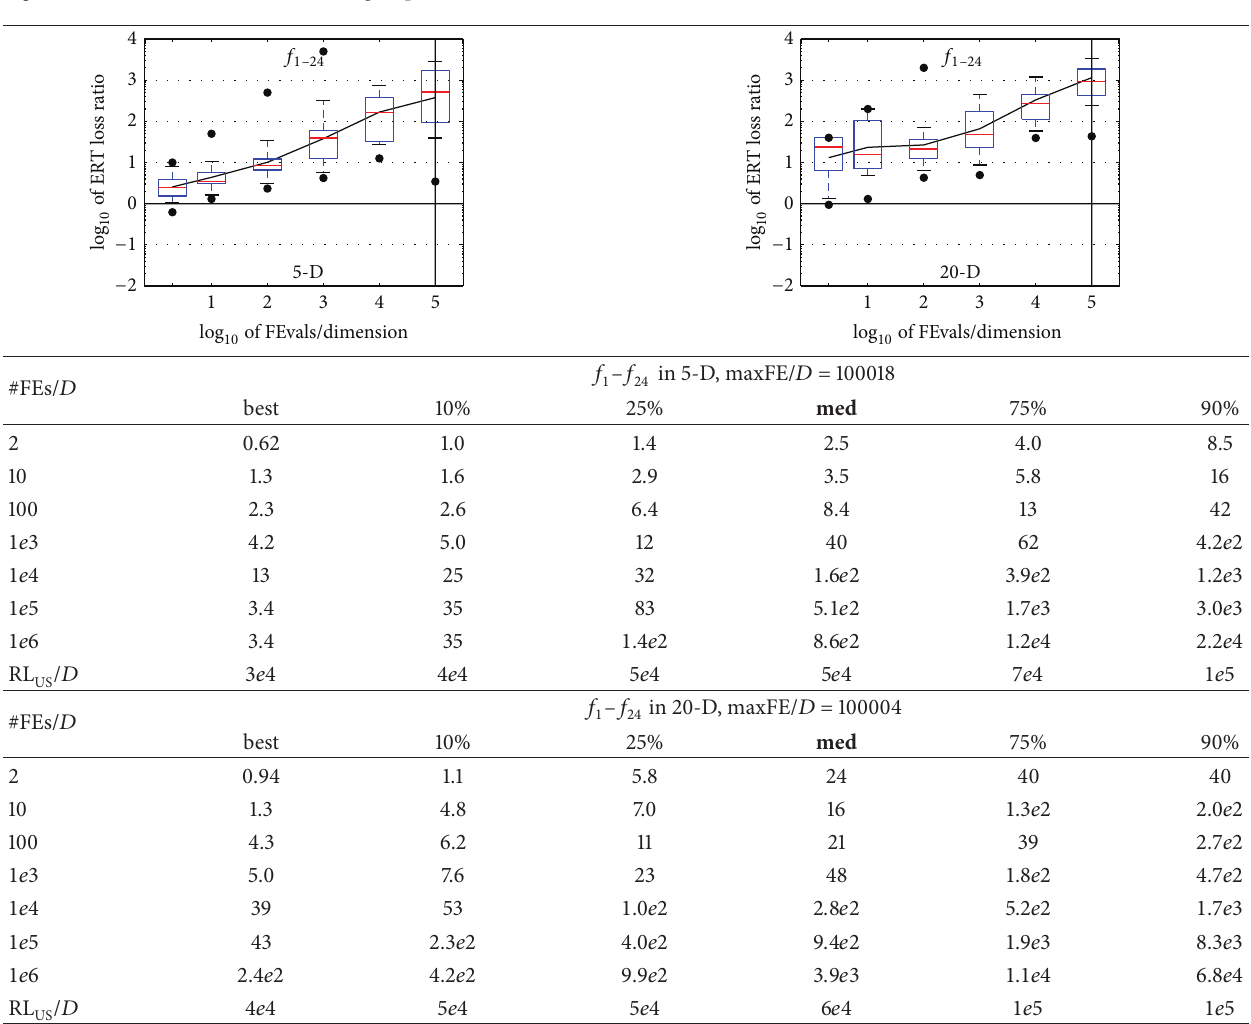
Table 2: ERT loss ratio versus the budget (both in number of 𝑓 -evaluations divided by dimension). The target value 𝑓 𝑡 for a given budget FEvals is the best target 𝑓 -value reached within the budget by the given algorithm. Shown is the ERT of the given algorithm divided by best ERT seen in GECCO-BBOB-2009 for the target 𝑓 𝑡 , or, if the best algorithm reached a better target within the budget, the budget divided by the best ERT. Line: geometric mean. Box-Whisker error bar: 25–75%-ile with median (box), 10–90%-ile (caps), and minimum and maximum ERT loss ratio (points). The vertical line gives the maximal number of function evaluations in a single trial in this function subset. See also Figure 3 for results on each function